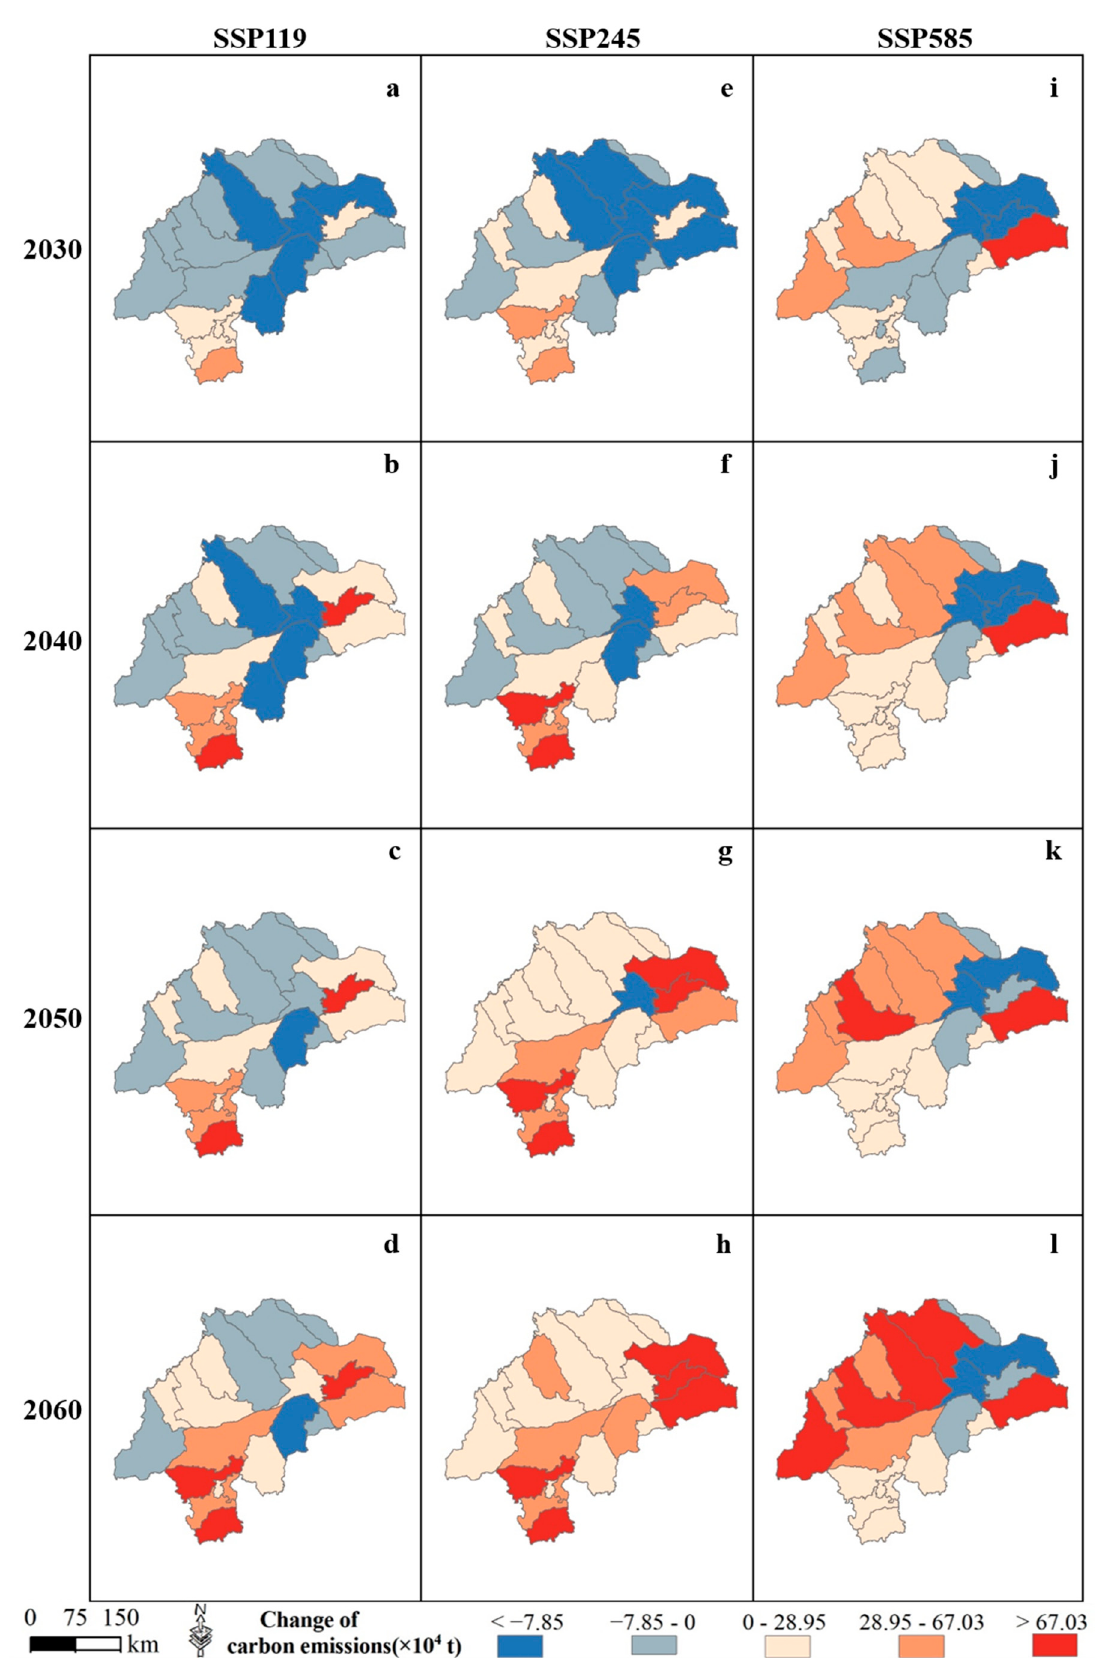
Figure 8. Changes in the spatial distribution of the carbon emissions compared to 2019 under SSP119 ( a – d ), SSP245 ( e – h ), and SSP585 ( i – l ) for four future periods: 2030s, 2040s, 2050s, and 2060s.